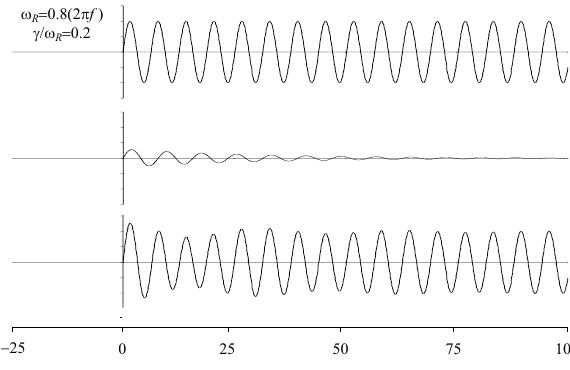
Fig. 12. Top panel: Directly driven reflected signal when ω R = 1 . 6 πf . Middle panel: Contribution from excited leaky waveg- uide mode. Bottom panel: